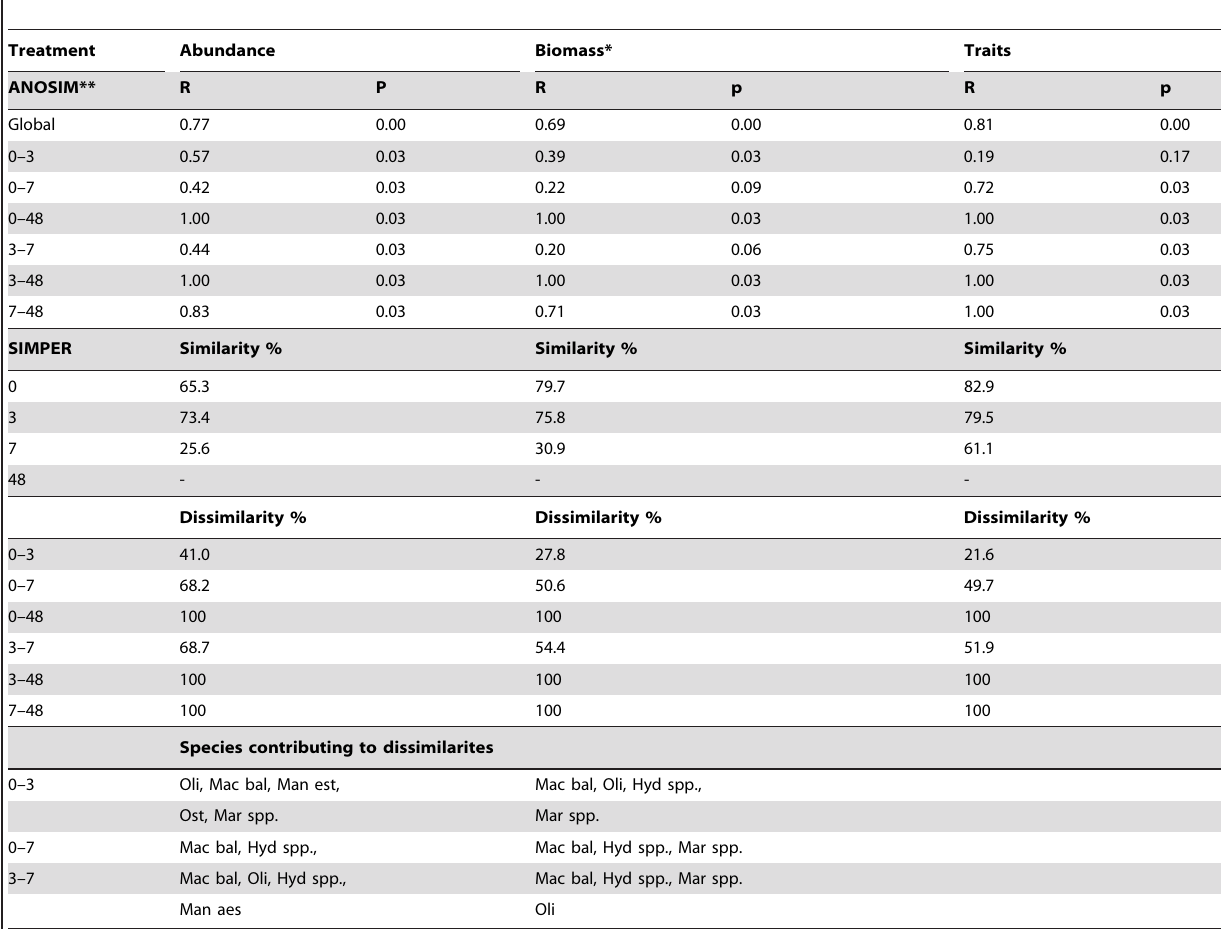
Table 1. Analysis of similarities (ANOSIM) comparing benthic community abundance, biomass and trait composition between treatments (0, 3, 7 and 48 days of